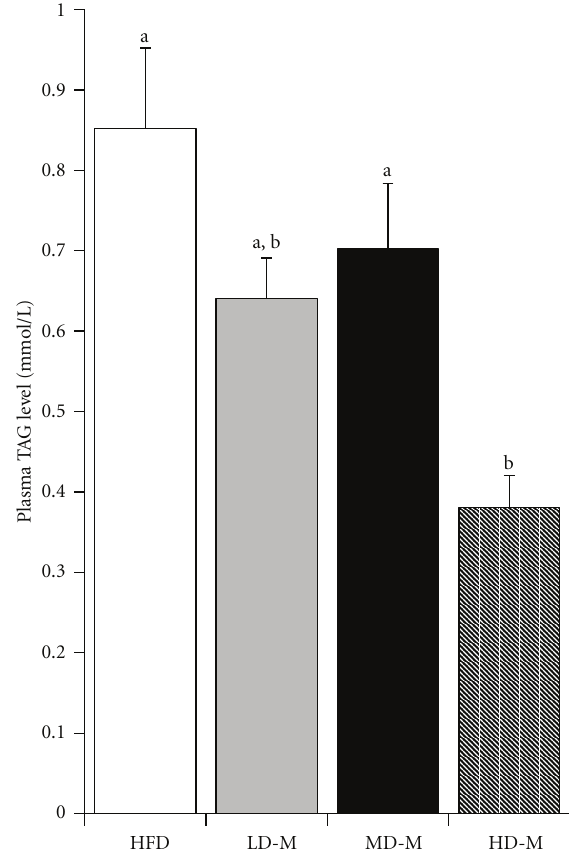
treatments in rats. Bars represent means ± standard errors, n = 10. For each variable, labelled means without a common letter di ff er, P < 0 .